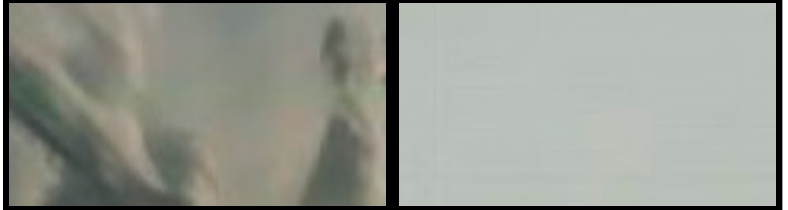
Figure 3. Preview of the edge effect: Left for a poorly trained network, right for a better trained network.